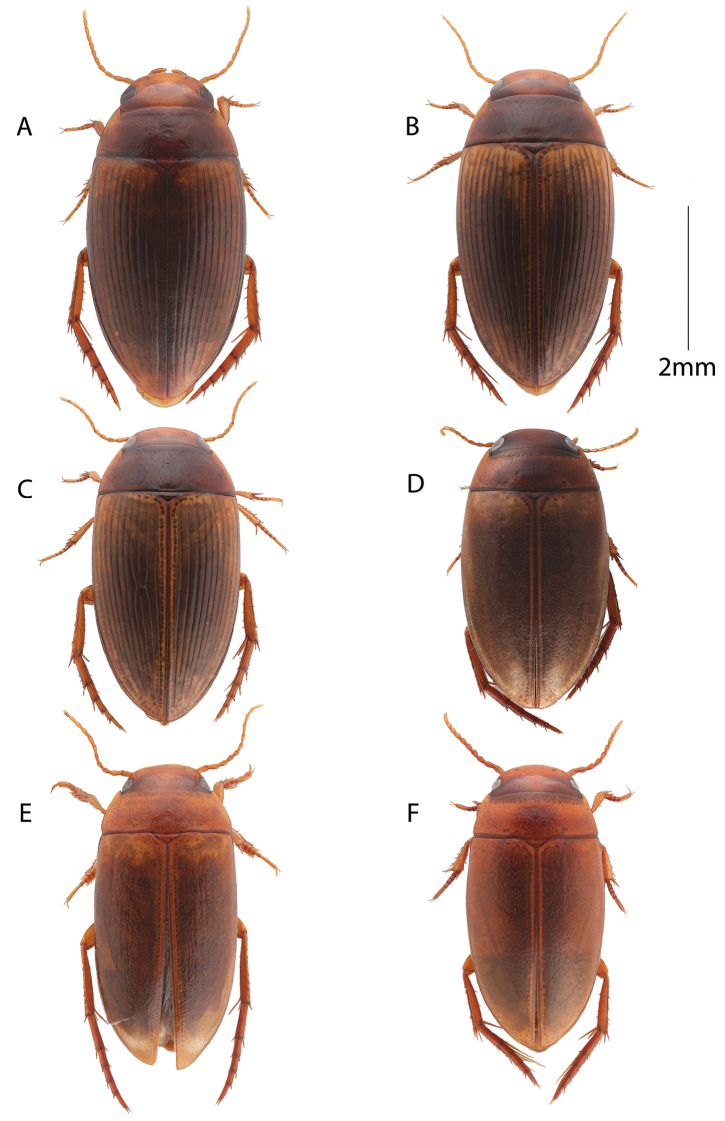
Habitus, dorsal view. ACopelatus
amphibius sp. nov. (female) BCopelatus
zanatanensis sp. nov. (female) CCopelatus
betampona sp. nov. (female) DMadaglymbus
semifactus sp. nov. (female) EMadaglymbus
kelimaso sp. nov. (male) FMadaglymbus
menalamba sp. nov. (female).